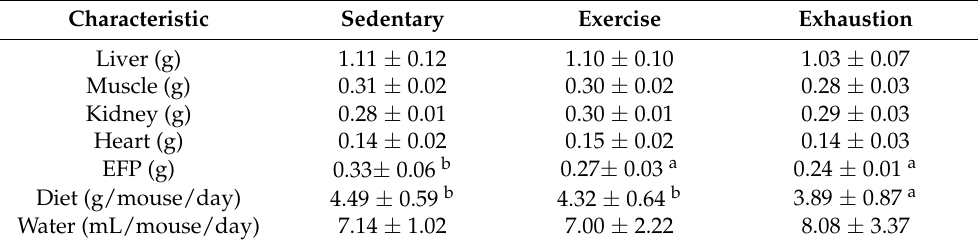
Table 1. Effects of consecutive exhaustive exercise intervention on body composition and diet.